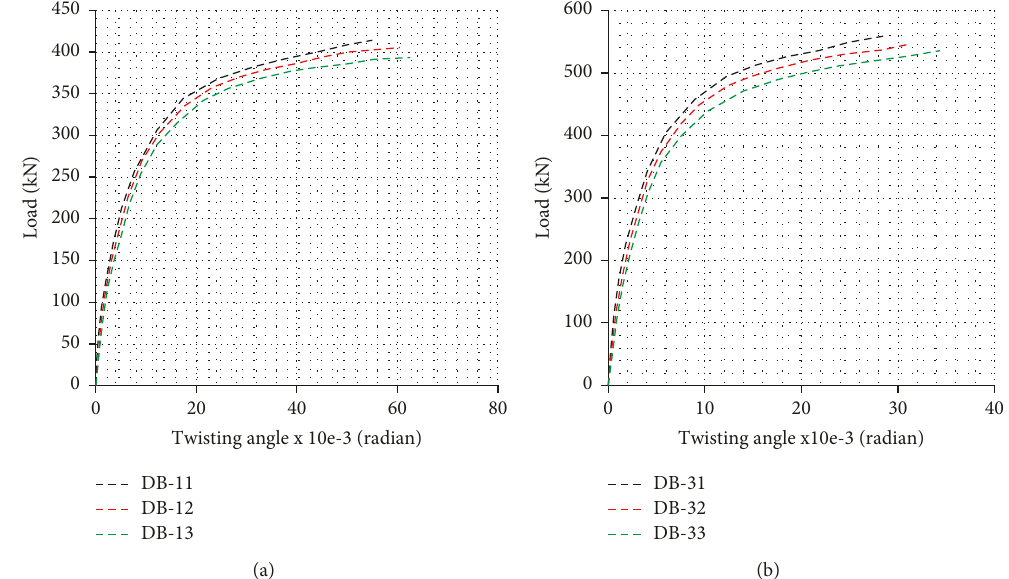
Figure 13: Load-rotation response curves with different L/R ratios of 1.05, 1.31, and 1.57. (a) Beam with L/D ratio equal to 3 and (b) beam with L/D ratio equal to